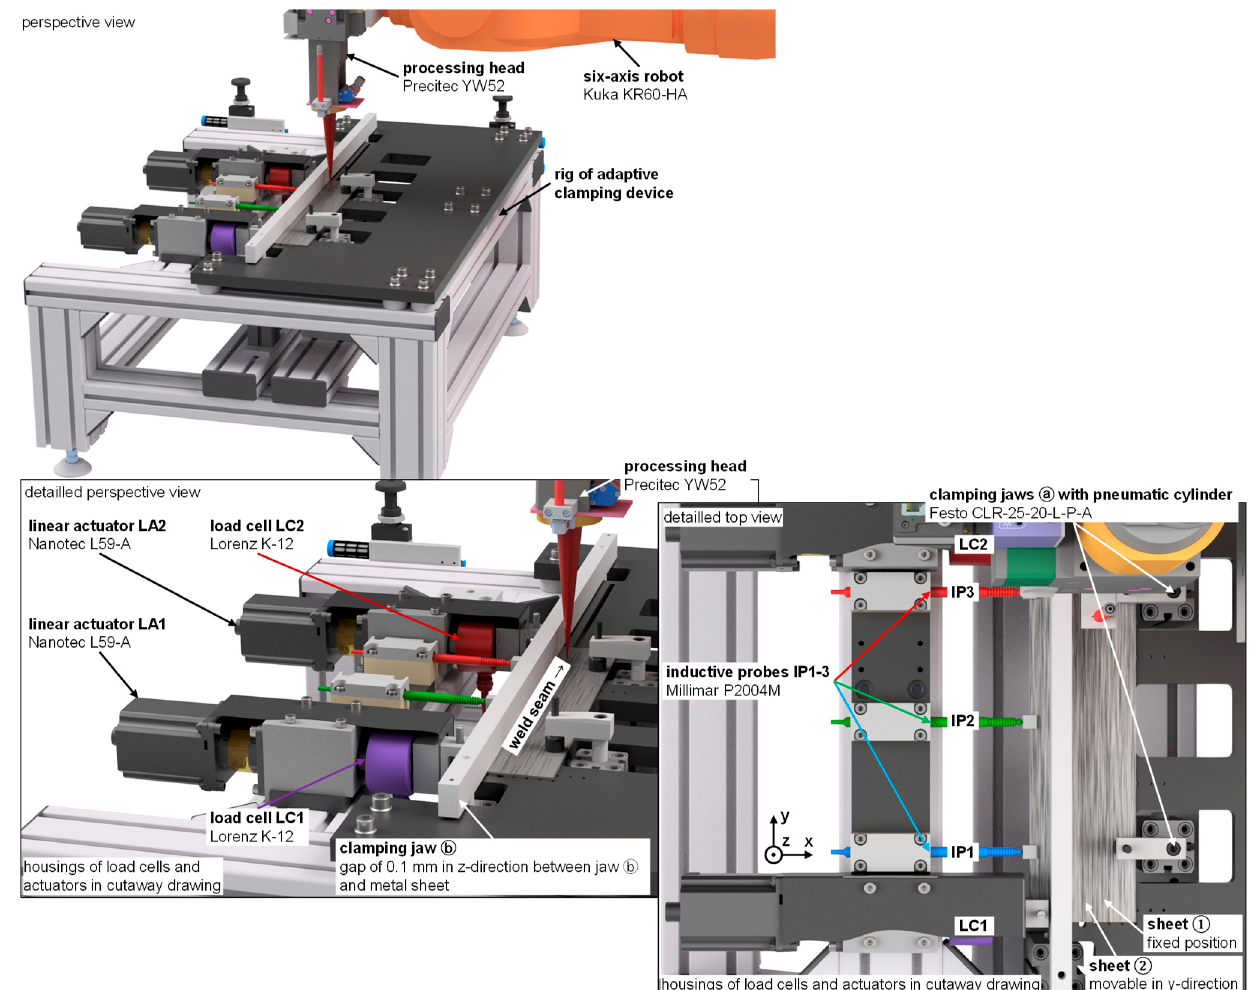
Figure 2. Design of the adaptive clamping device in perspective and top view